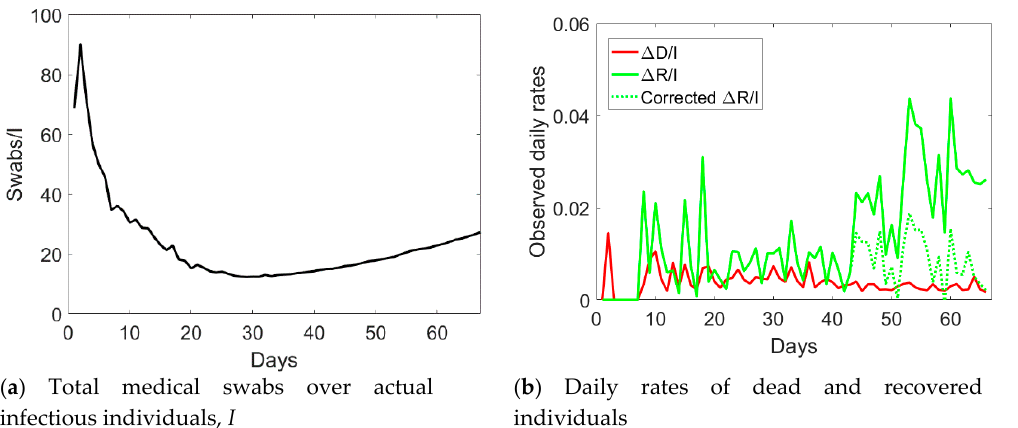
Figure 6. Ratio between the total number of medical swabs and the actual number of infected individuals, I ( a ), and daily rates of dead and recovered individuals ( b ) in Veneto from 24 February